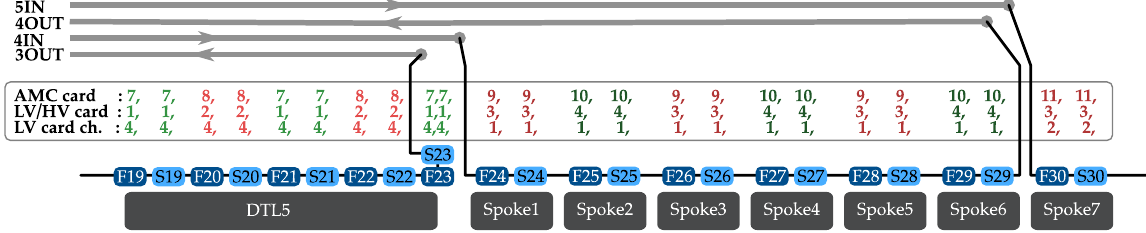
FIG. 2. Detector and cabling layout for DTL tank 5 and initial 7 subsections of the Spoke section. Each Spoke subsection consists of two parts, a so called linac warm unit (LWU) with a pair of quadrupole magnets and a cryomodule housing two spoke cavities. Light and dark blue squares, respectively, indicate nBLM-S and nBLM-F detector locations along these linac sections. Which AMC, HVand LV card number as well as LV card channel number each detector connects to is represented with green or red numbers stated above the detector. Here green and red color respectively mark odd and even detector group type. For example, detectors F19, S19, F21, S21, S23, and F23 belong to one of the odd groups and connect to AMC card 7, HV card 1 and the fourth channel on LV card 1. Similarly, detectors F20, S20, F22, and S22 belong to one of the even groups and connect to AMC card 8, HV card 2, and fourth channel on LV card 2. Shade of green and red color indicates different BEE racks, namely AMC cards 9 and 11 sit in the same rack, while card 8 is located in a different rack. Gas loops for circulating the gas through a series of detectors are indicated with grey and black lines representing the long haul and flexible tubes, respectively. Here “ IN ” refers to a distribution and “ OUT ” to a return long haul gas pipe. For example, the fourth gas loop circulates the gas through detectors in the first 6 Spoke